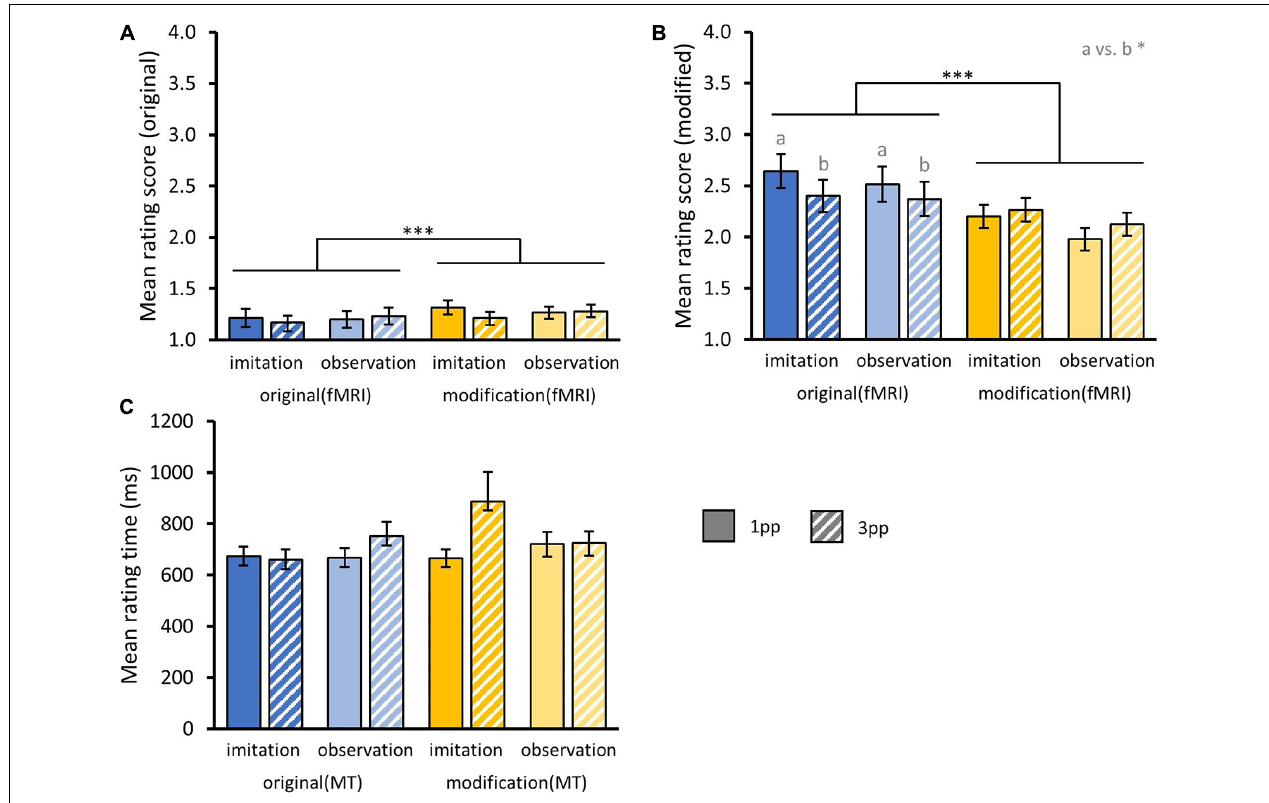
FIGURE 10 | Behavioral results from post-fMRI memory test. (A) Mean rating scores for original and (B) modified videos from memory test separated by the factors AGENCY (imitation, observation) and PERSPECTIVE (1pp, 3pp) and fMRI presentation mode MODIFICATION (original, modified). Statistics: rmANOVA based on aligned ranks with post hoc paired t -tests; a vs. b = p < 0.05. (C) Overall mean rating times for correct and incorrect responses from memory test. (A–C) Bar charts show means and standard